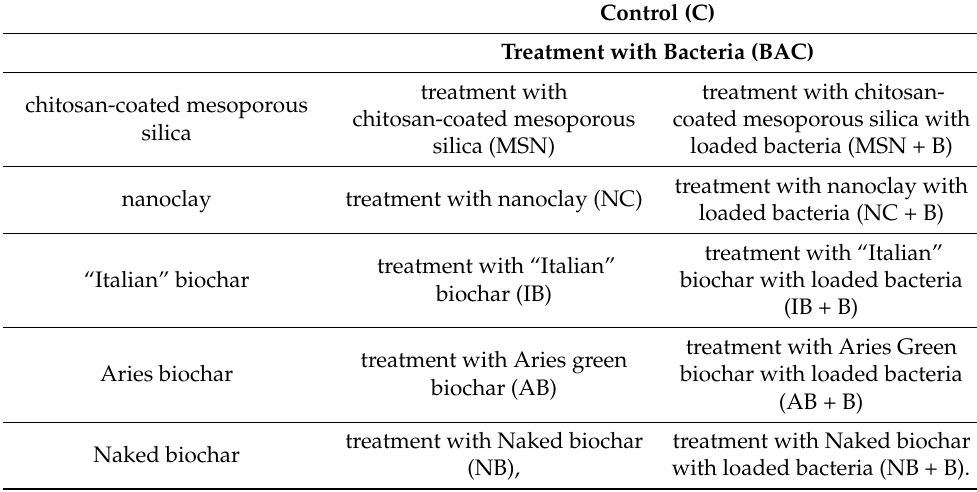
Table 1. Treatments used in